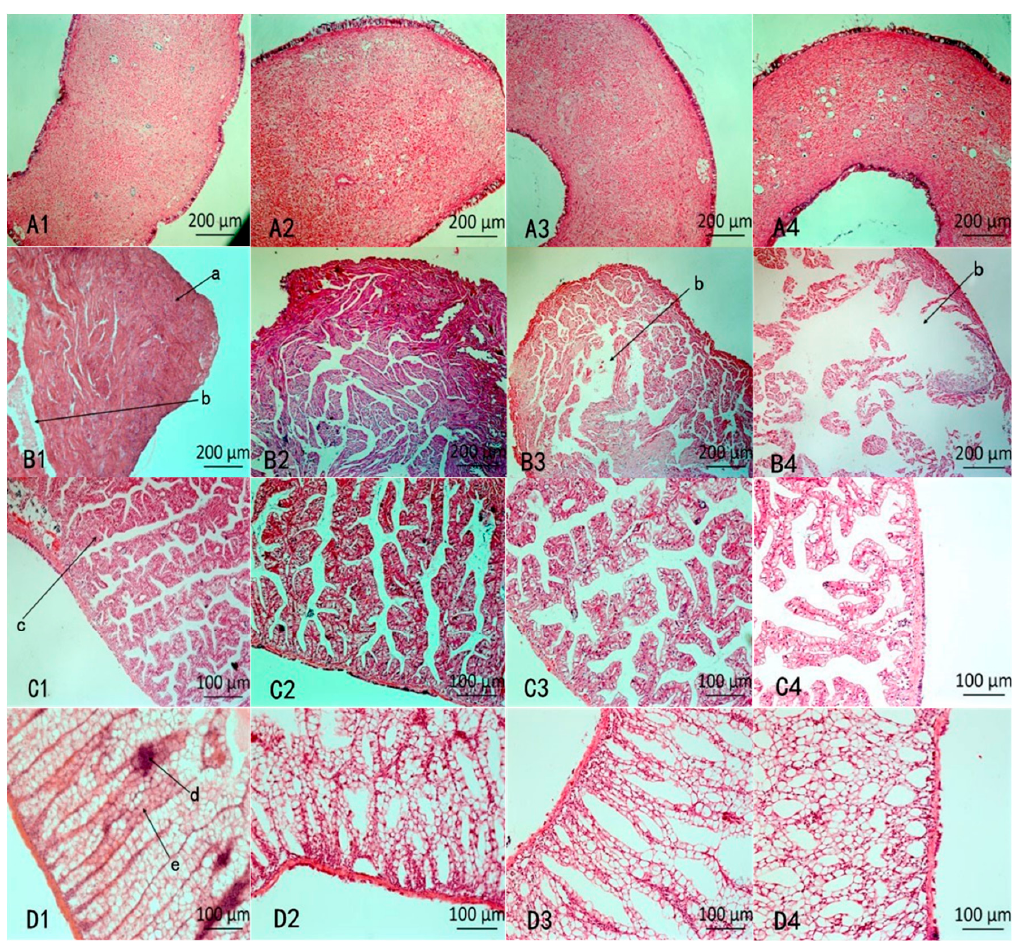
Figure 4. Histopathological changes in various organs. ( A1 – D1 ) represent CK (water treatment), ( A2 – D2 ) represent PA treatment, ( A3 – D3 ) represent NI treatment, ( A4 – D4 ) represent MI treatment; A: Siphon; B: Ventricle; C: Pericardial gland; D: Kidney; a: muscle fiber; b: gap; c: parenchyma cell; d: collecting tube e: kidney tubules;.